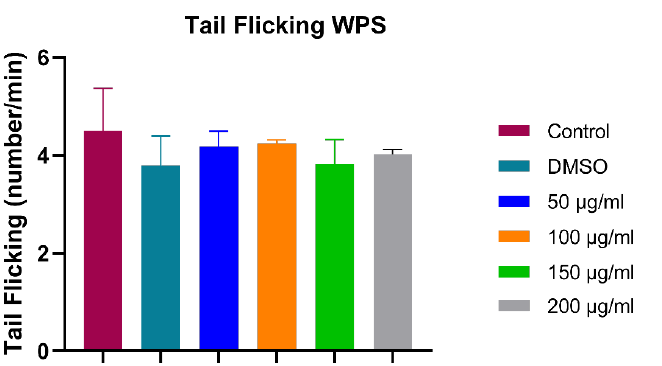
Figure 4. Assessment of potential neuromuscular toxicity at 24-hpf by tail flicking assay. All data are presented as mean ± SEM (50 embryos were used in each group; the experiment was performed in triplicate). One-way ANOVA with Sidak post hoc test was used to compare the differences be- tween